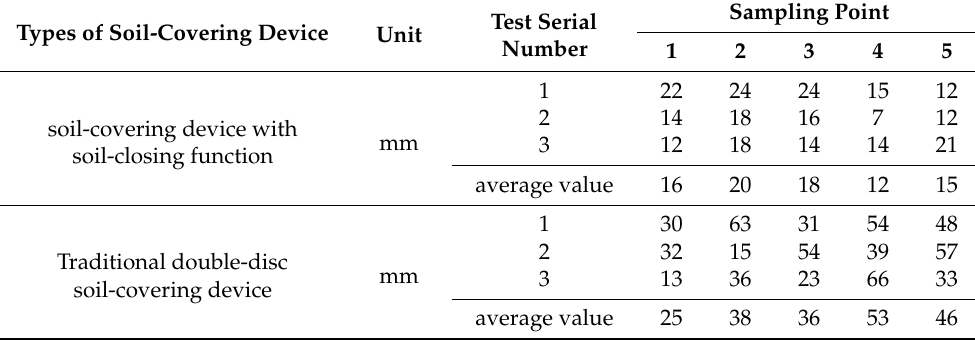
Table 7. Measurement results of seed offset difference at the sampling point.